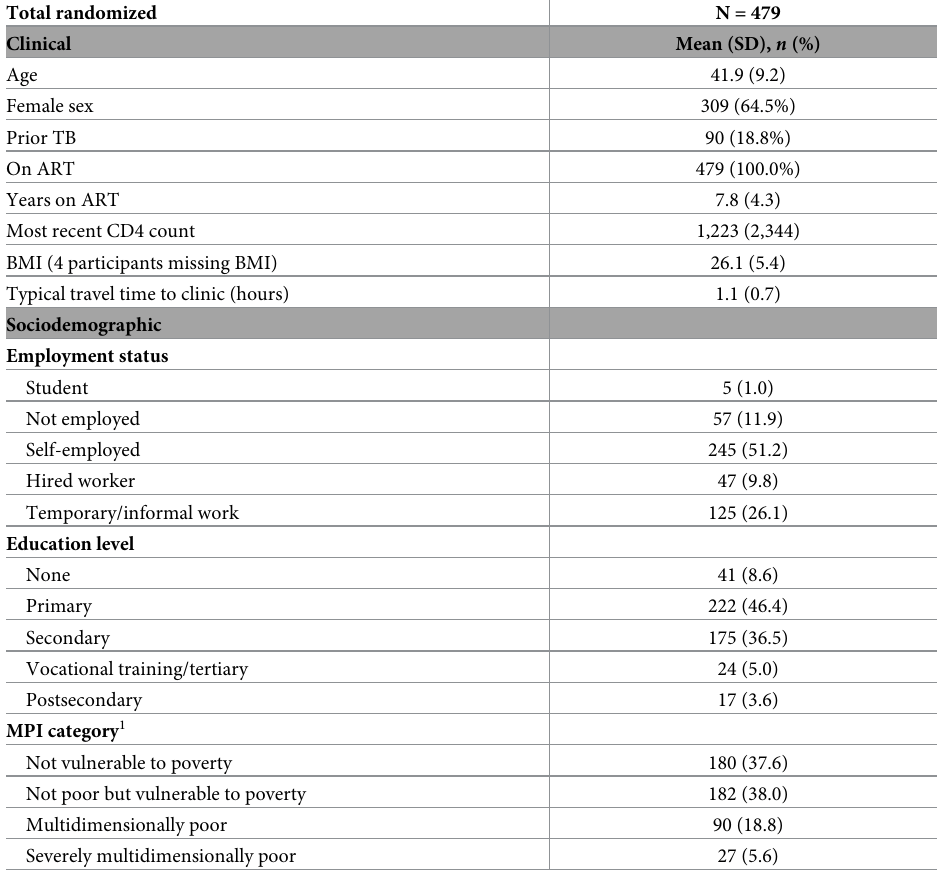
Table 1. Baseline demographic and clinical characteristics. 3HP Options Trial participants, July 13, 2020 to April 30, 2021 ( n =